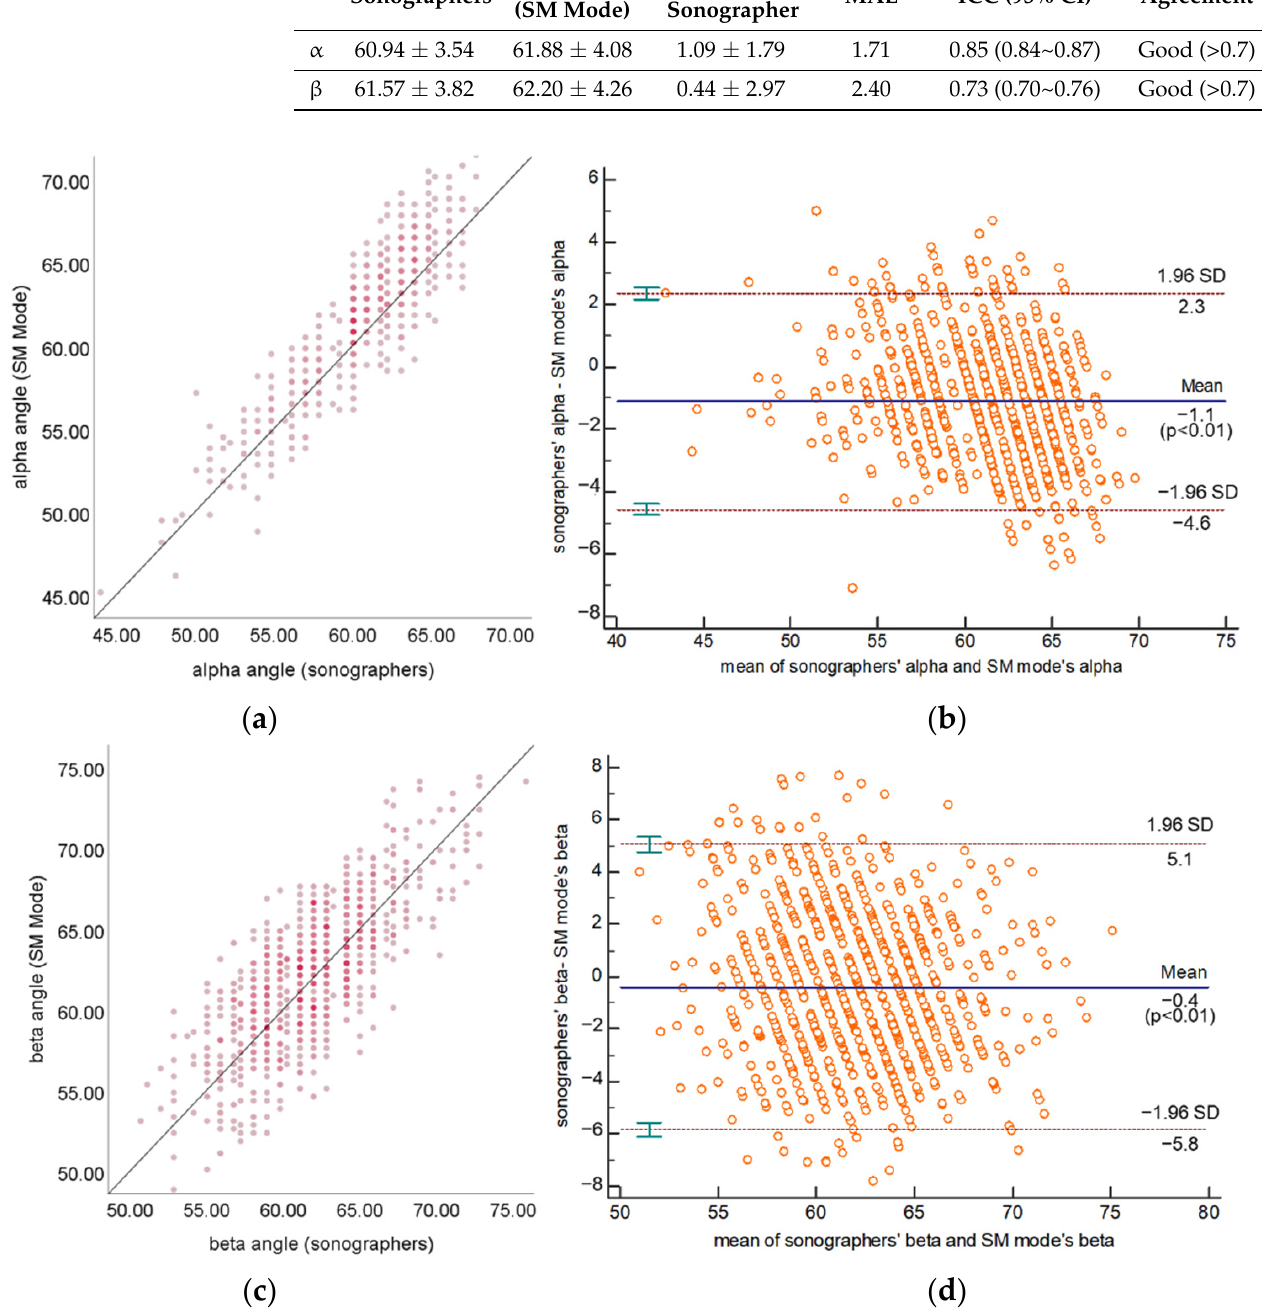
Table 2. Comparison of angle measurement between SM mode and sonographers.